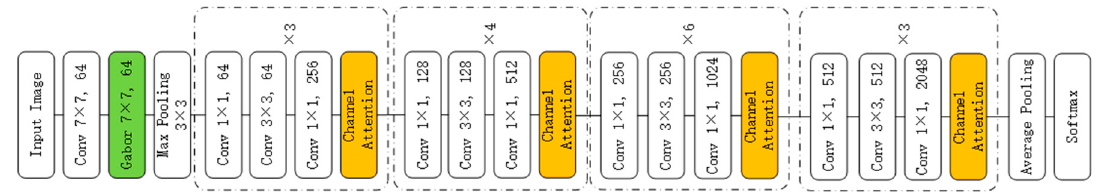
Figure 2. Gabor-CA-ResNet network structure.